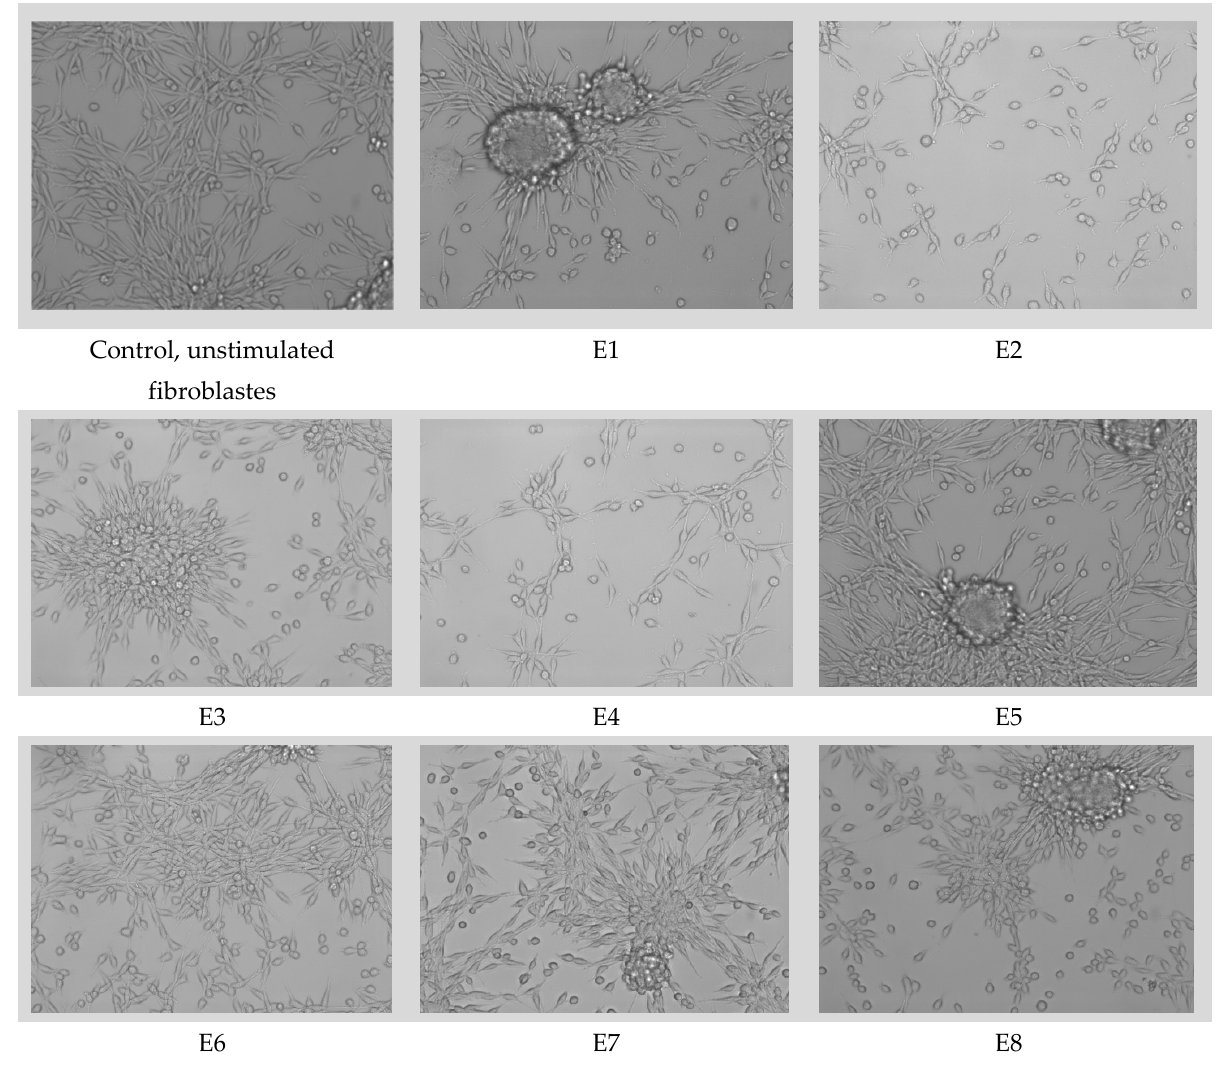
Figure 15. Cell morphology of the fibroblasts for the sample materials loaded with essential oils.